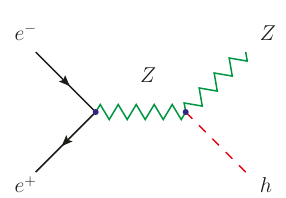
Figure 1. LO process: e − ( p 1 ) + e + ( p 2 ) → Z ( k 1 ) + h ( k 2 )